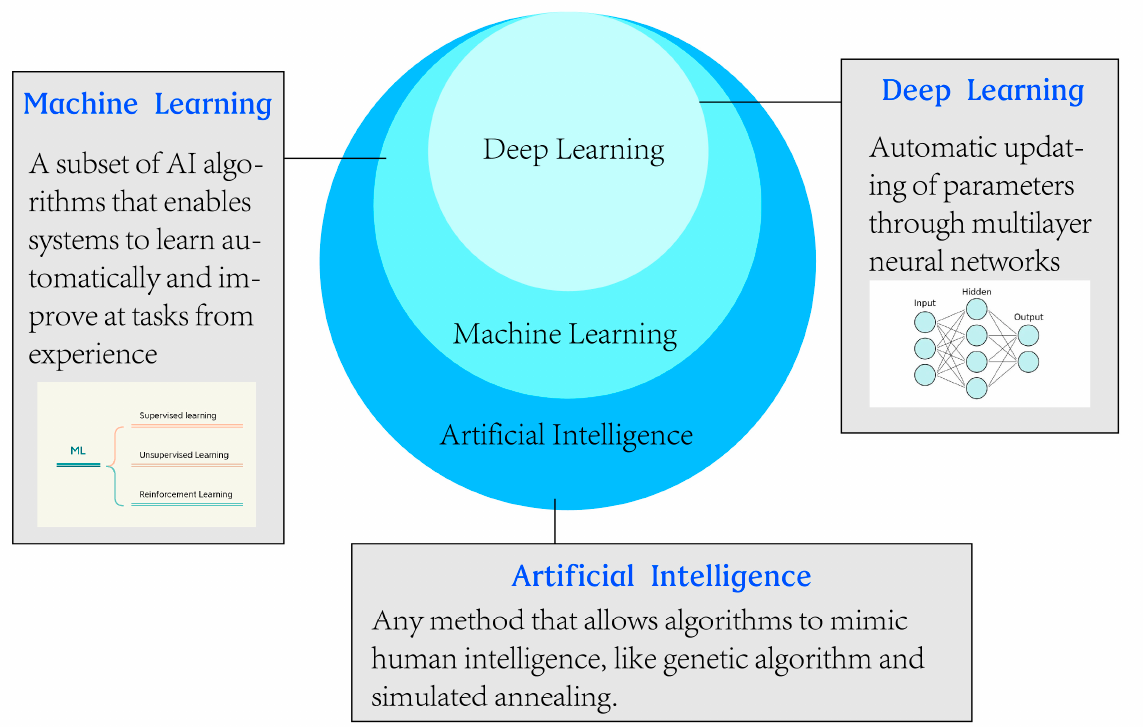
Figure 1. The differences and relationships among artificial intelligence (AI), machine learning (ML), and deep learning Figure 1. The di ff erences and relationships among arti fi cial intelligence (AI), machine learning (ML), and deep learning (DL).